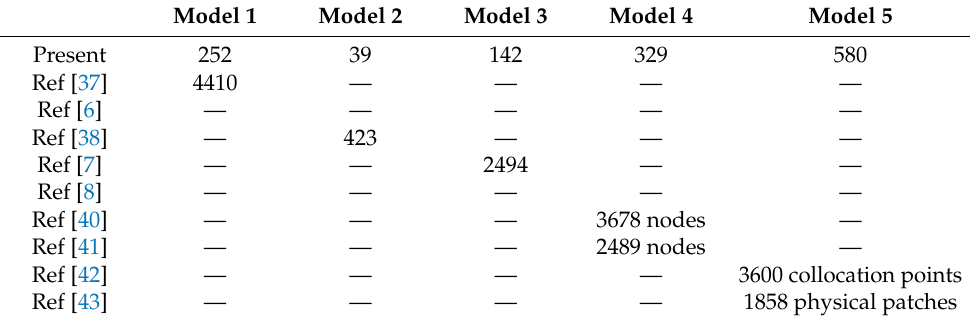
Table 11. The numbers of elements used for different numerical